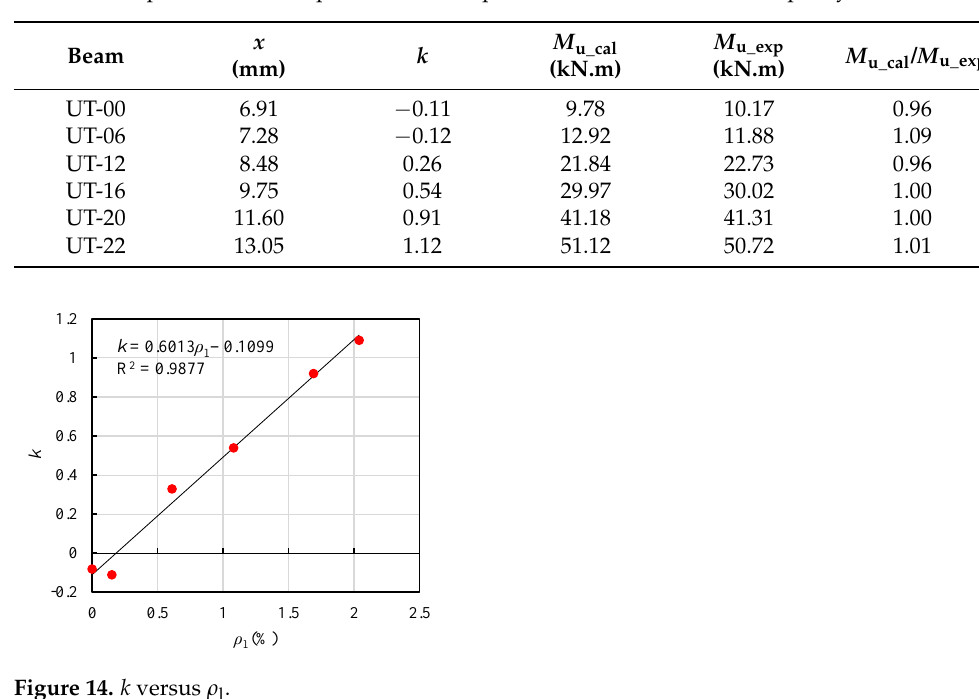
Table 7. Comparison between predicted and experimental ultimate flexural capacity.